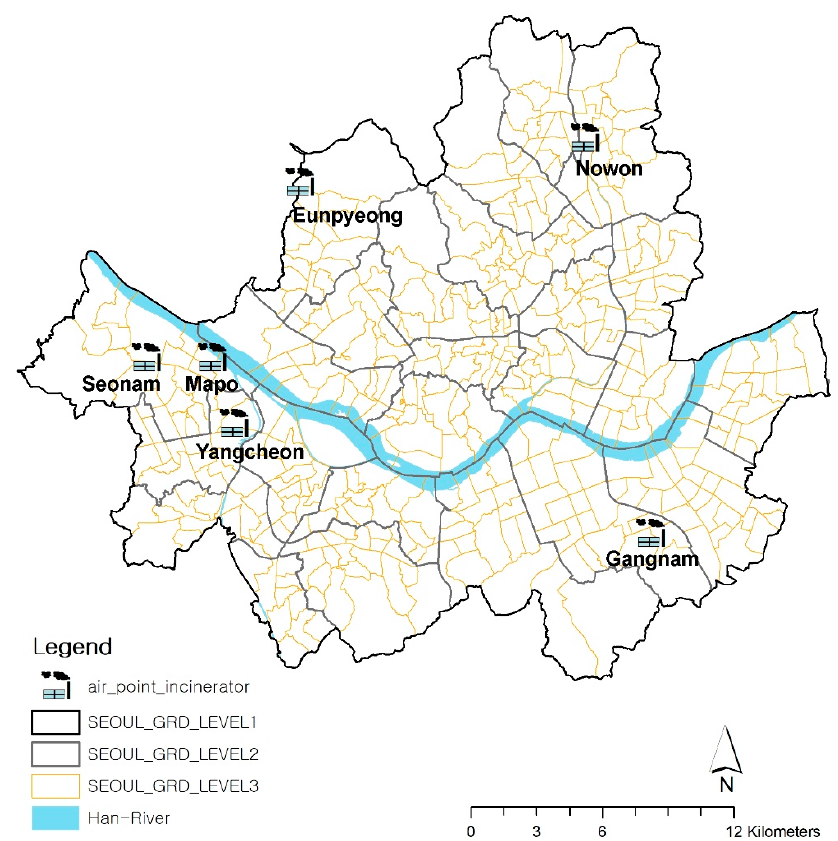
Figure 1. Location of Incineration Facilities, Seoul.